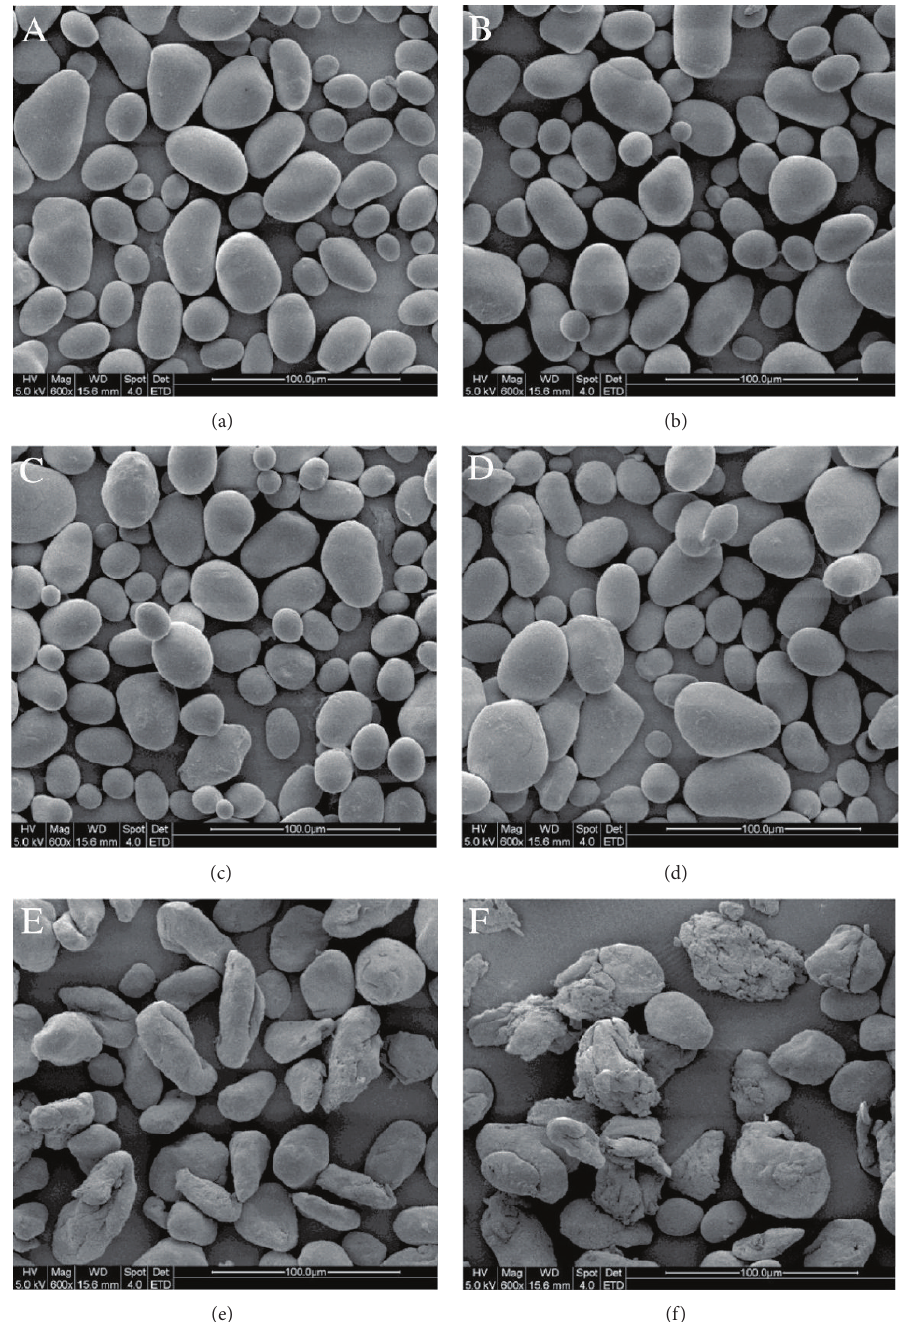
Figure 6: SEM micrographs of (a), (b) native starch and (c), (d), (e), and (f) microwave treated for 5, 10, 15, and 20 seconds, respectively